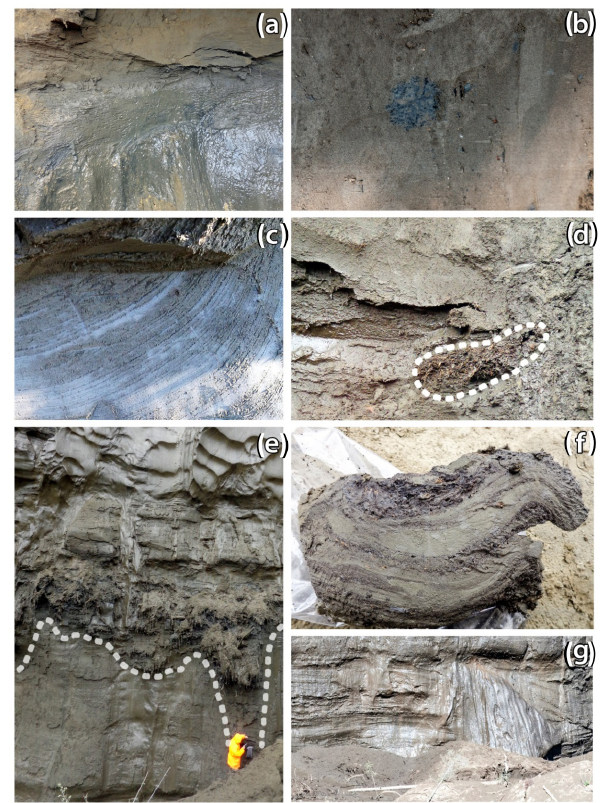
Figure 7. Typical sediment and cryostructures at the Batagay ex- posure. (a) Contact zone between the active layer, Unit I, and YIC, Unit II (section C). (b) Charcoal inclusions and iron oxide impreg- nations in Unit I (section A) at 0.20–0.43mb.g.s. (c) Horizontally layered cryostructure of Unit II (section C). (d) Fossilized ground squirrel nest (dated ca 26kaBP) at 4.7mb.g.s. in Unit II (sec- tion A). (e) Organic-rich deposits filling a palaeo-depression ca. 42mb.g.s. in section B; the person illustrates the position where sample no. 21.6/B/1/43 was taken. (f) Sample no. 21.6/B/1/43 in frozen state showing alternate bedding of sand and plant detritus layers. Thickness of the upper plant detritus layer is about 5cm. (g) Ice-rich deposits in layered cryostructure enclosed by syngenetic ice wedges several metres thick in Unit